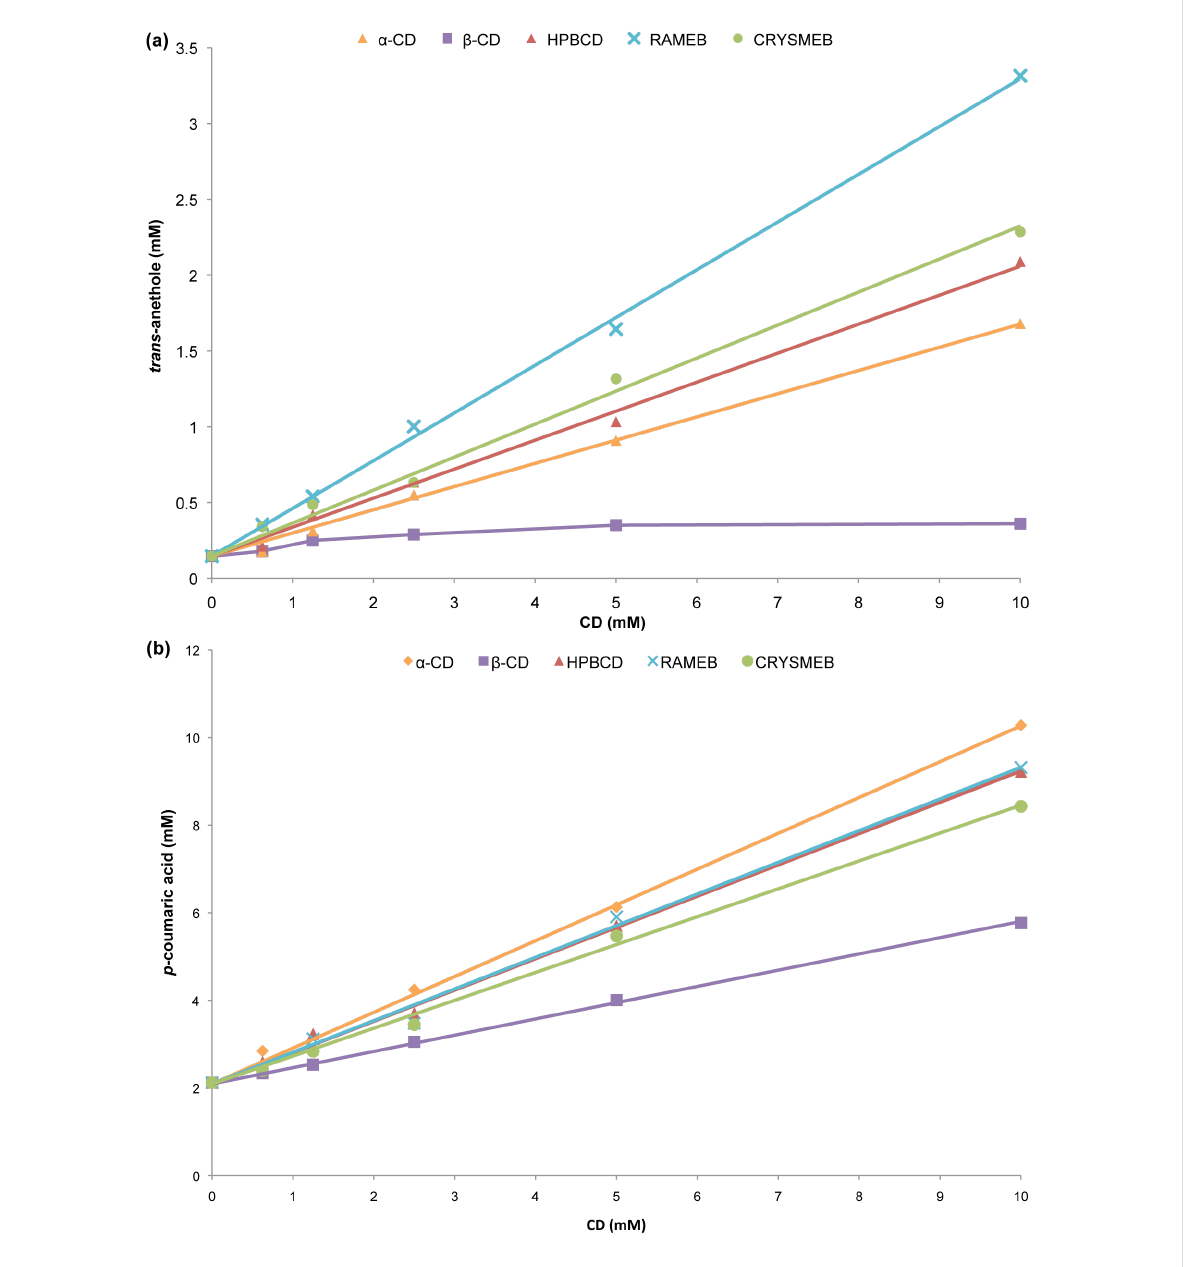
Figure 2: Phase solubility profiles of (a) CD/ trans -anethole and (b) CD/ p -coumaric acid inclusion complexes.